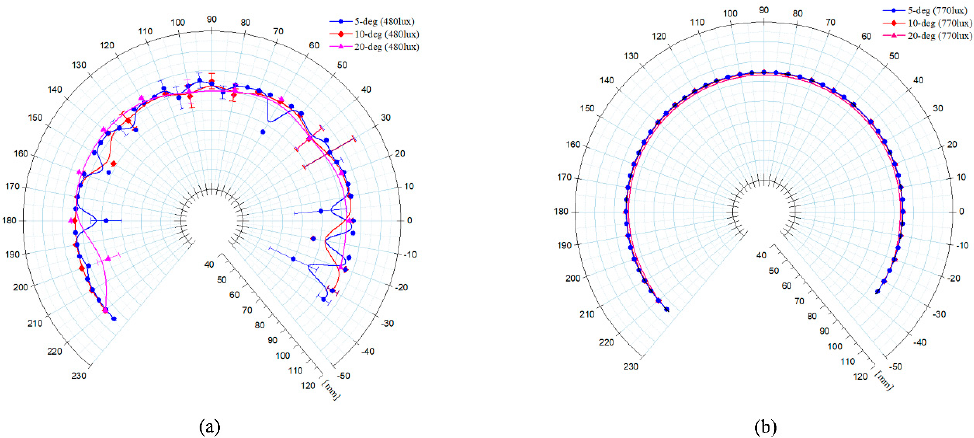
Figure 17. Results of circle fittings with respect to the frame {C} for different angle shifting intervals and LED light intensities: ( a ) 480 lux; ( b ) 770 lux.